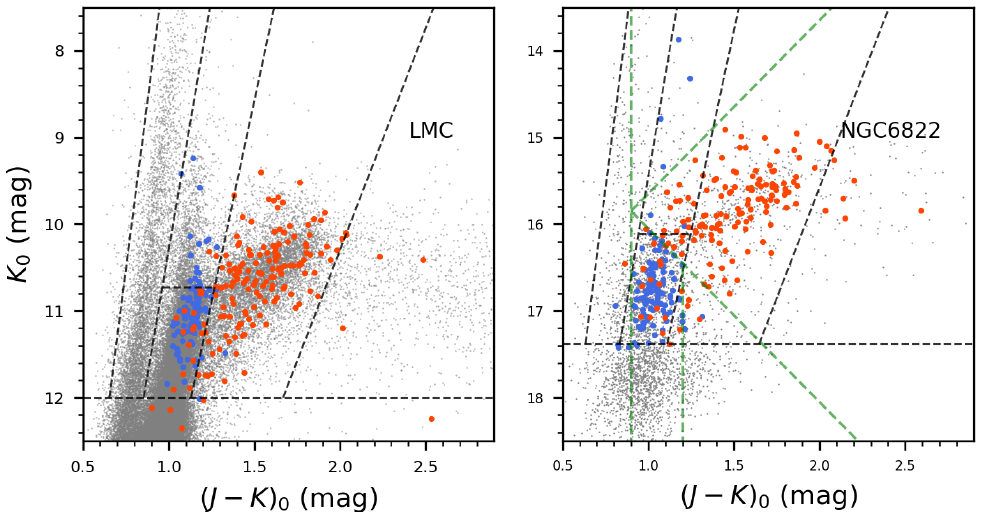
Figure 6. The previous spectroscopic classifications of AGB stars in the LMC (left) and NGC6822 (right) are used for the validation of our J / J − K CMD photometric method. The C-AGBs stars and O-AGBs identified from previous spectral observations are indicated by red and blue dots, respectively. The black dashed line represents the borderlines in our work, and the green dashed line in the right panel represents the borderlines suggested by Kacharov et al. [78] based on the result of the NGC 6822 AGB stars’ spectroscopic